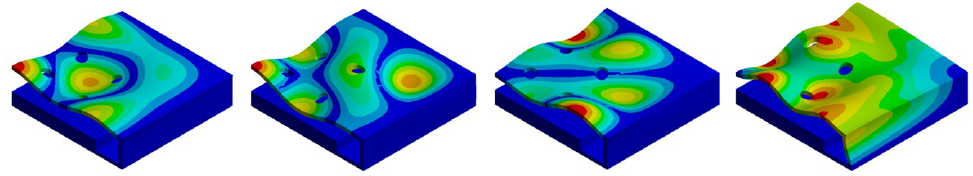
Figure 20. Four package modes for case (c): 6th mode shape at 80.18 kHz ( left ), 7th mode shape at 102.66 kHz ( center-left ), 8th mode shape at 102.66 kHz ( center-right ), 16th mode shape at 151.01 kHz ( right ).